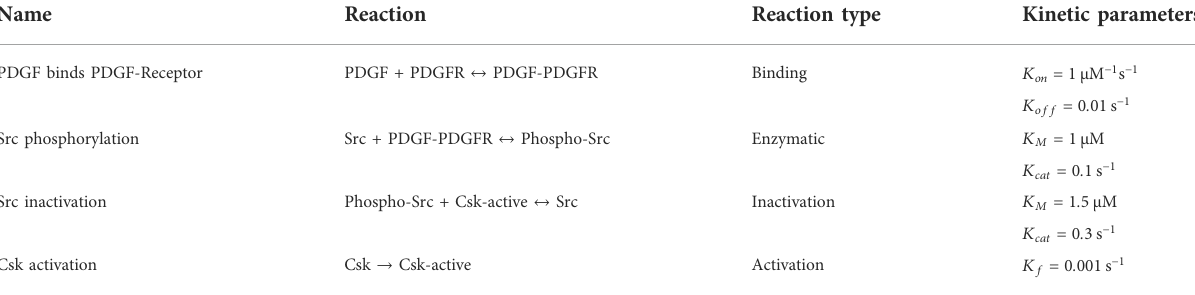
TABLE 1 Reactions and kinetic parameters for modeling Src activation upon PDGF stimulation (Rangamani et al., 2013). Name